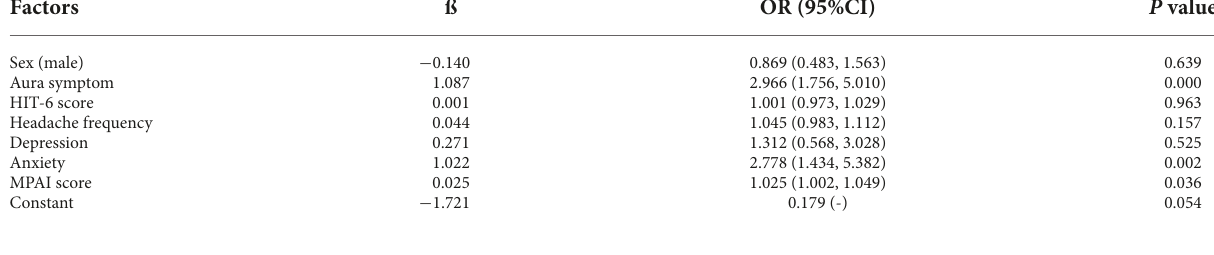
TABLE 4 Multivariate logistic regression analysis of factors associated with sleep quality in migraine patients.